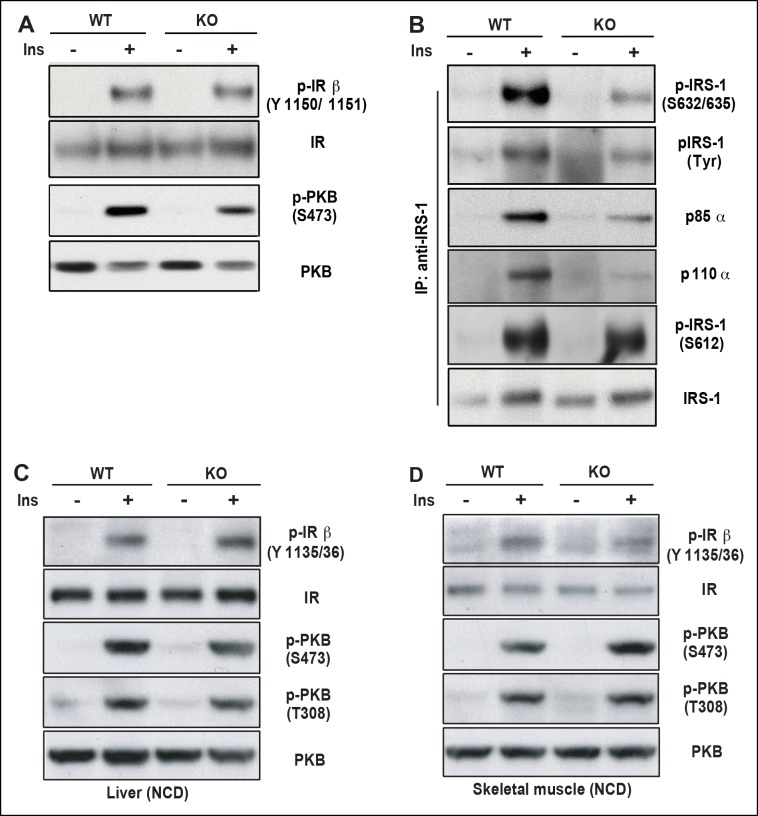
PDZ-RhoGEF is required for optimal IGF-1 signaling output in EWAT.(A) IR phosphorylation and differential PKB/Akt phosphorylation in WT and PDZ-RhoGEF KO EWAT in response to insulin. (B) Serine phosphorylation of IRS1 and interaction between IRS1 and PI3K in WT and PDZ-RhoGEF KO EWAT in response to insulin. (C) IR phosphorylation and differential PKB/Akt phosphorylation in WT and PDZ-RhoGEF KO liver in response to insulin. (D) IR phosphorylation and differential PKB/Akt phosphorylation in WT and PDZ-RhoGEF KO skeletal muscle in response to insulin.